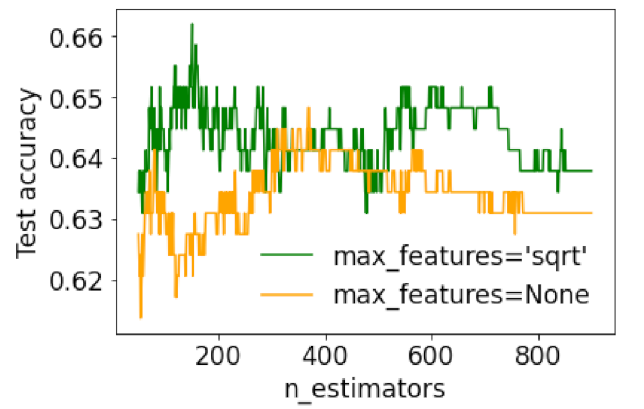
Figure 6. Test set accuracy as a function of the parameter n_estimators, i.e., the number of trees in the forest, which was computed with the parameter max_features set to